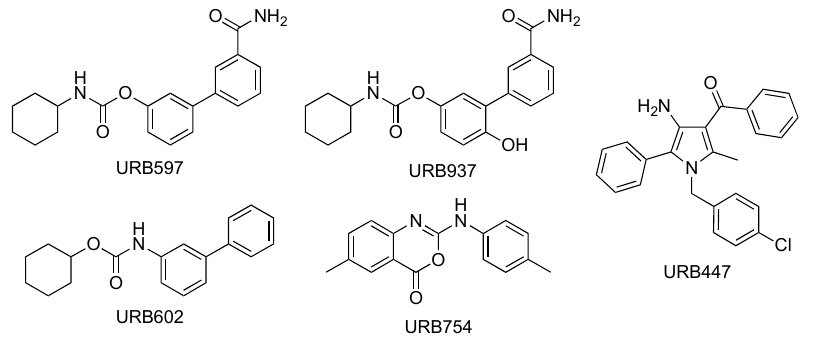
Figure 1. Chemical structures of URB compounds.